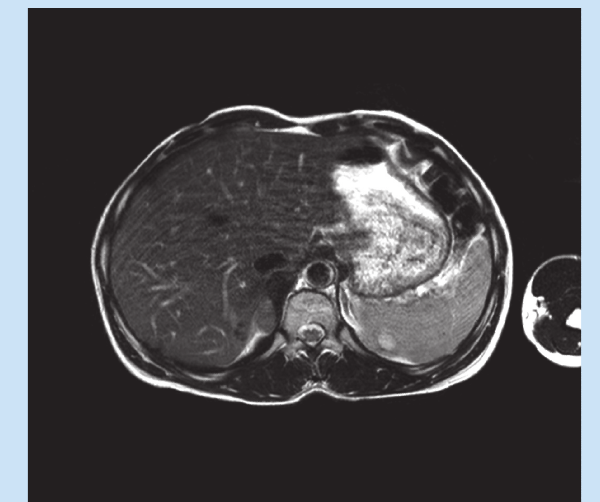
Fig. 2. Axial T2 (TR 2.01/TE 100) weighted MRI sequence demonstrates a right adrenal mass which has higher signal compared with the liver but lower signal compared with surrounding fat.